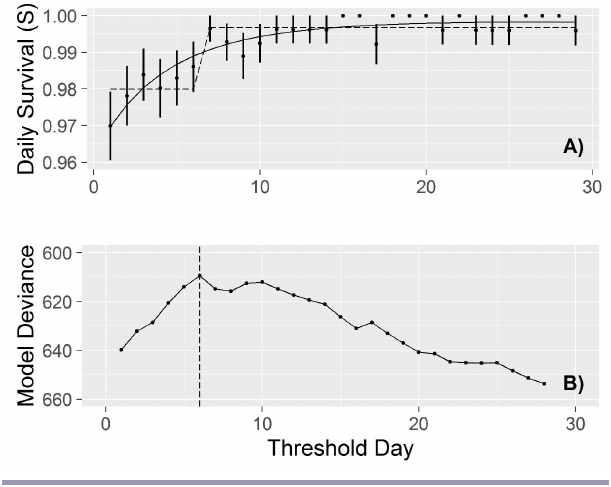
Table 1 . Model selection results for nest survival analyses that Fig. 1 . Daily survival probabilities (A) and model deviance (B) describe the daily survival probability of Ruffed Grouse ( Bonasa from analysis of radio-marked Ruffed Grouse ( Bonasa umbellus ) for the first 30 days following release and radio- umbellus ) survival during the first 30 days following release. For marking. Models were implemented in Program MARK using panel A, point estimates of daily survival (error bars reflect the R package RMark (Laake 2016). Temporal models took one 95% confidence intervals) were derived from a model allowing of three forms: a model allowing full daily variation, daily trend full independence among daily estimates. The solid line reflects models (linear, quadratic, natural log), and a series of models a quadric trend in daily survival, and the dashed line represents identifying discrete threshold points of postrelease mortality. a model that identified a threshold in mortality that occurred between days 6 and 7. Panel B represent differences in model deviance among all potential daily thresholds for postrelease Model † AIC Deviance c mortality. The y-axis is inverted, and smaller deviance values Quadratic Trend + Base indicate better fit, where the best-fit model is indicated by the dashed vertical line. All models were ran as nest survival analyses, implemented in Program MARK (White and Burnham 1999) using the R package RMark (Laake 2016).